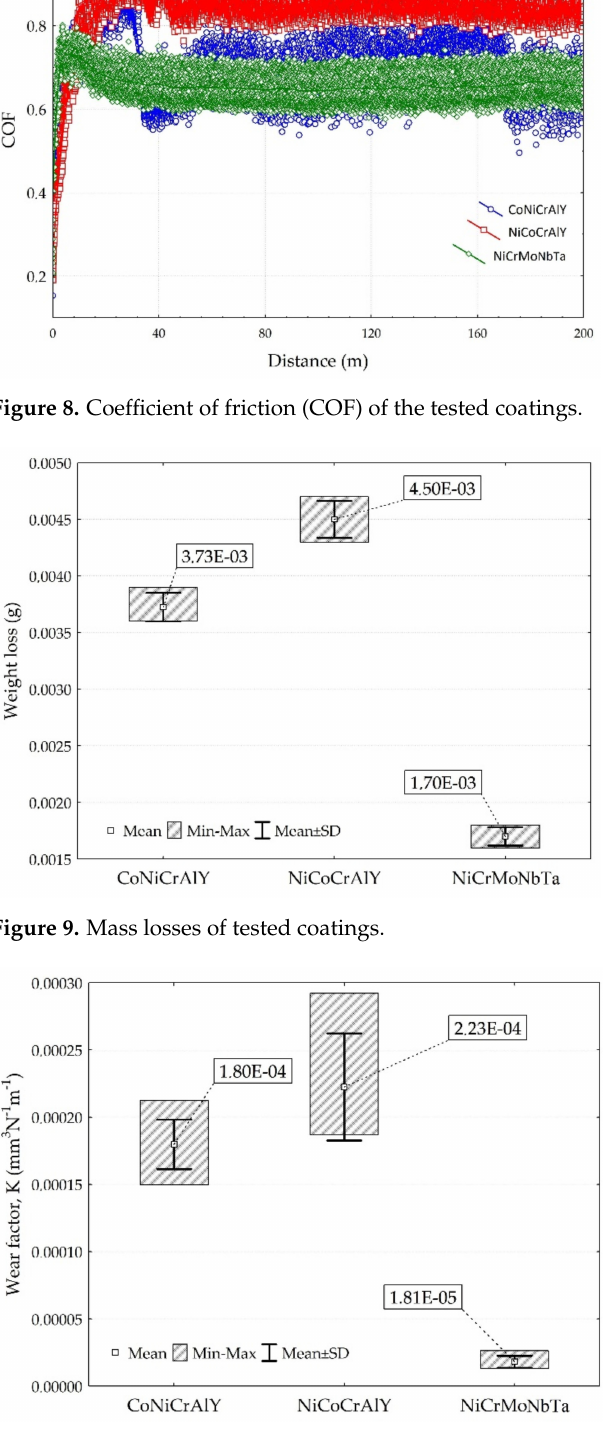
Figure 10. Sliding wear result of investigated